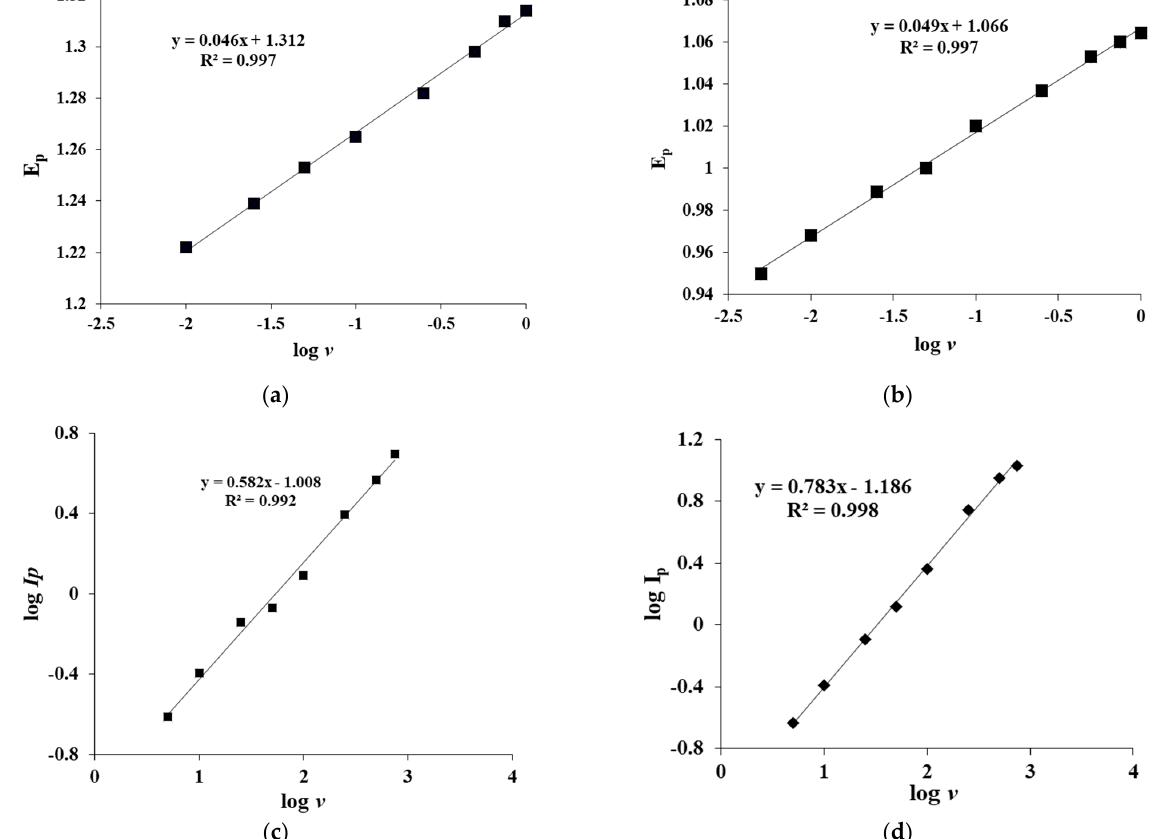
Figure 3. Results of scan rate studies: ( a ) E p vs. log v , ( b ) log I p vs. log v for 0.1 mM ROS, ( c ) E p vs. log v , and ( d ) log I p vs. log v for 0.1 mM EZE in H 2 SO 4 .